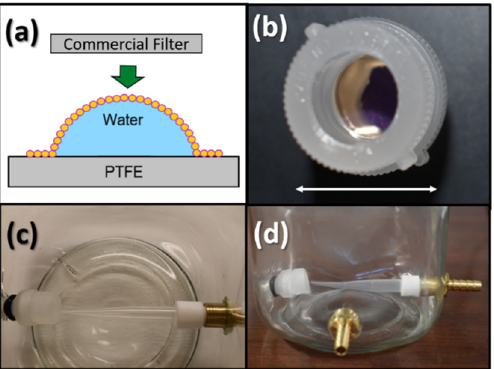
Figure 3. ( a ) The stamping process which transfers the USANP monolayers to the polycarbonate filters; ( b ) the machined polypropylene filter housings with USANP-functionalized polycarbonate filter installed, where the white arrow below indicates the length scale of 18 mm; ( c ) the top view looking down inside the custom filtration chamber; ( d ) the side view of the custom filtration cham- ber.